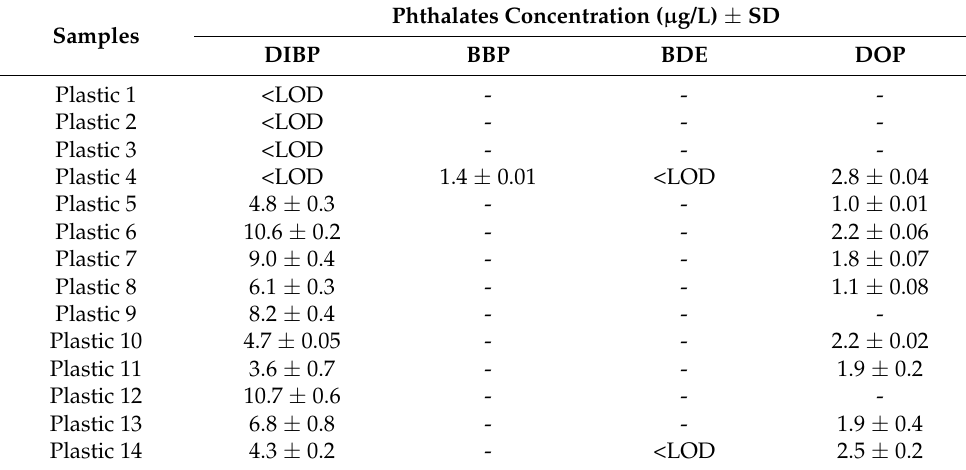
Table 4. Occurrence of phthalates in plastic-based food packages.